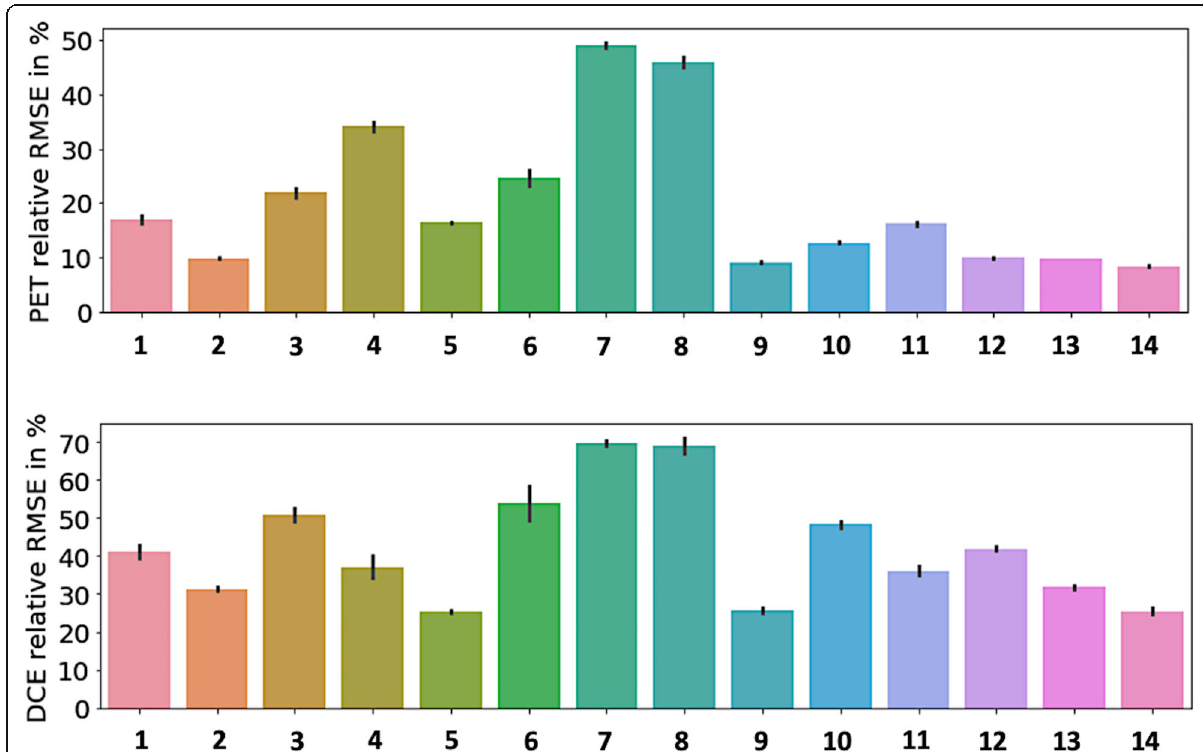
Fig. 2 Curve fitting results for PET and DCE kinetic modeling. For each tumor ( x -axis), voxel-wise relative root mean square errors (relative RMSE) are provided ( y -axis). For each tumor, the vertical black lines are the standard